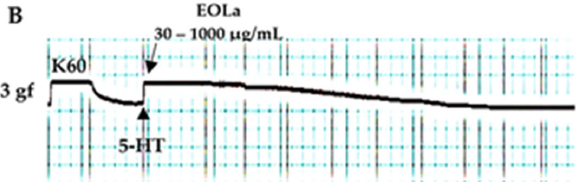
Figure 3. Relaxant effect of EOLa and evaluation of pharmacomechanical coupling by 5-HT (10 µ M) in HUA. ( A ) “Log-normal” plot for the effect of EOLa (30–1000 µ g/mL) on serotonin-induced contractions in HUA; values are expressed as the mean ± SEM; n = 6 ( p < 0.01, one-way ANOVA). ( B ) Original recording in LabChart Pro software for relaxant effect of EOLa on the pharmacomechanical coupling induced by 5-HT in HUA.